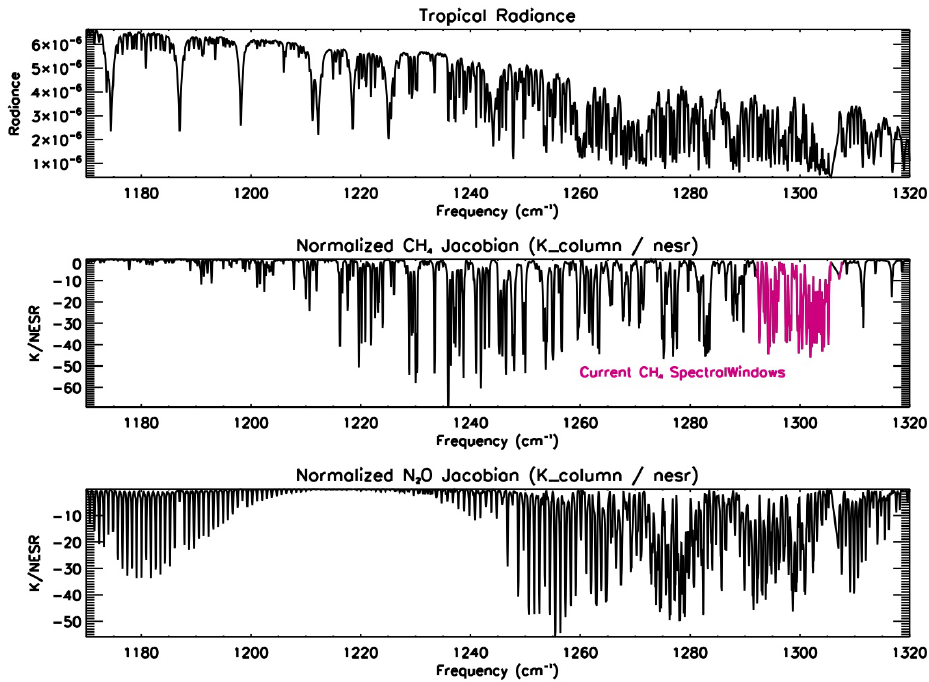
Fig. 1a. (Top) Example of radiance measured by TES over a tropical ocean scene. (Middle) Sensitivity of TOA radiance to (log) CH 4 , integrated over the whole atmospheric column and normalized by the TES NESR. (Bottom) Same as middle but for N 2 O. The red shaded area indicates the spectral region used for TES Version 4 methane retrievals.